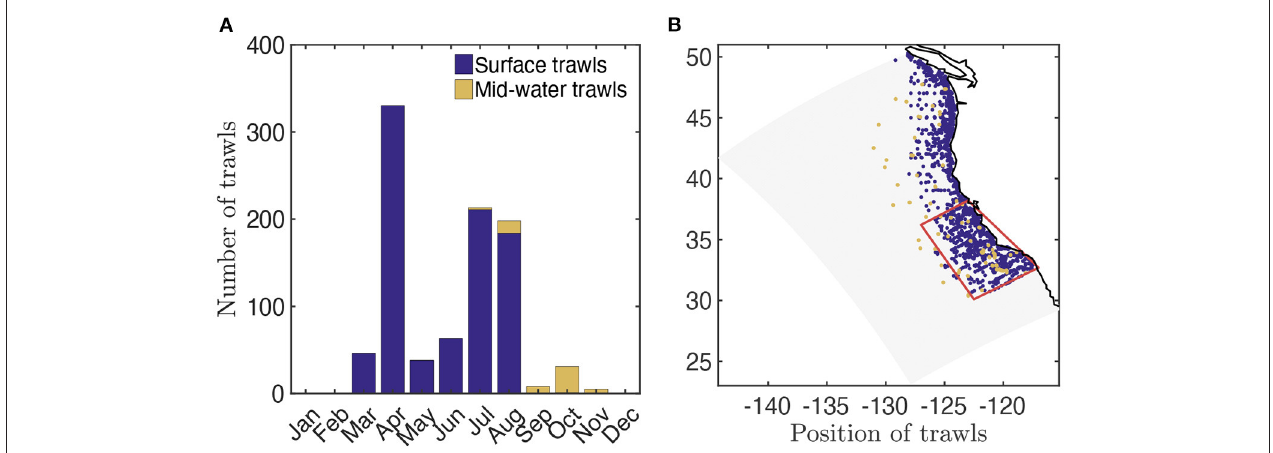
FIGURE 2 | Trawl data in the California Current. (A) Total number of fisheries independent trawls per month. (B) Spatial distribution of fisheries independent trawls (blue, surface trawls; orange, mid-water trawls) and focus region for fish biomass time-series reconstruction (red).